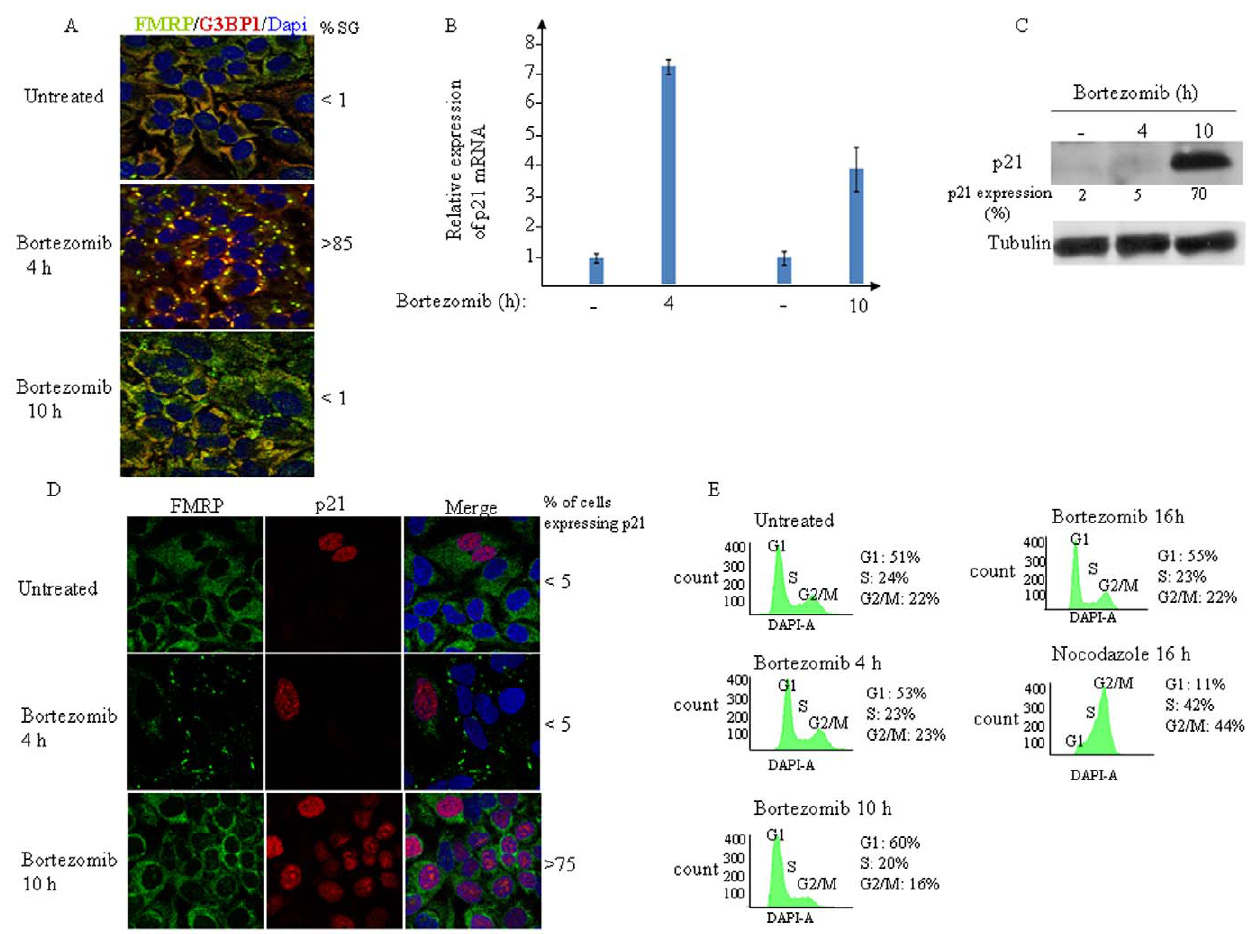
Figure 1. Bortezomib upregulates p21 mRNA expression. (A) HeLa cells were treated with 2 m M bortezomib for 4 h or 10 h, fixed, permeabilized, and then processed for immunofluorescence using antibodies against different SG markers. DAPI is used as a nuclear stain. Pictures were taken using 63X objective. The percentage of cells harboring SG ( . 3 granules/cell) from five different fields and three different experiments containing a total of 1000 cells is indicated. (B) qRT-PCR of p21 mRNA. Following treatment with bortezomib for the indicated period, cells were collected and total RNA content was then isolated. The amount of p21 was quantified by real time-PCR relative to GAPDH mRNA using the DD Ct method. Results are expressed as the mean 6 SEM (error bars) of triplicate measurements. (C) HeLa cells were treated with 2 m M bortezomib for the indicated time, and the level of p21 was analyzed by western blotting using specific antibodies ( top panel). Tubulin is used as a loading standard. The amount of p21 was determined by quantitation of the signals on films by densitometry using Adobe Photoshop software and expressed as a percentage relative to the amounts of tubulin. The results are representative of five different experiments. (D) HeLa cells were treated as in (A). p21 protein was detected using anti-p21 antibodies and SG were visualized with anti-FMRP antibodies. (E) Bortezomib does not affect cell cycle at the time points analyzed. Cells were treated with 2 m M bortezomib or with 0.8 m g/ml nocodazole for the indicated interval, collected, washed with PBS, and then fixed with 3% paraformaldehyde for 20 min. Cells were washed with PBS, stained with DAPI (1 m g/mL) and analyzed by flow